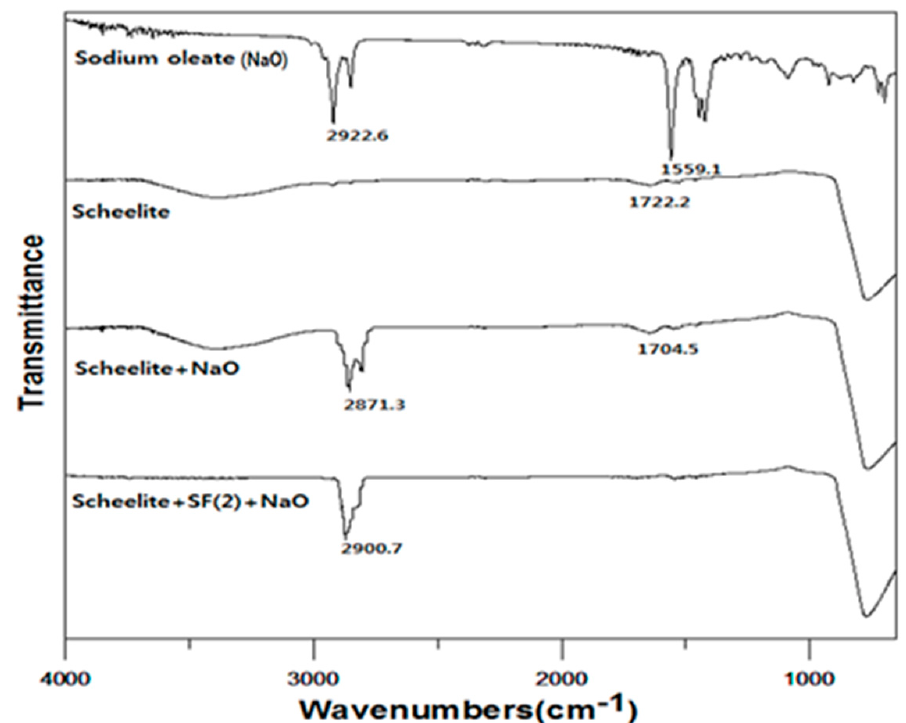
Figure 9. Fourier-Transform Infrared (FTIR) analysis result of scheelite at the optimum flotation conditions.